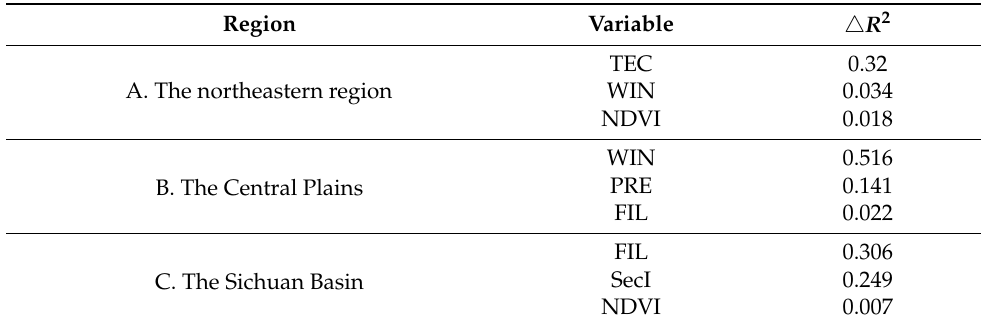
Table A4. Ranking of the importance of influencing factors associated with significant spatial heterogeneity in typical